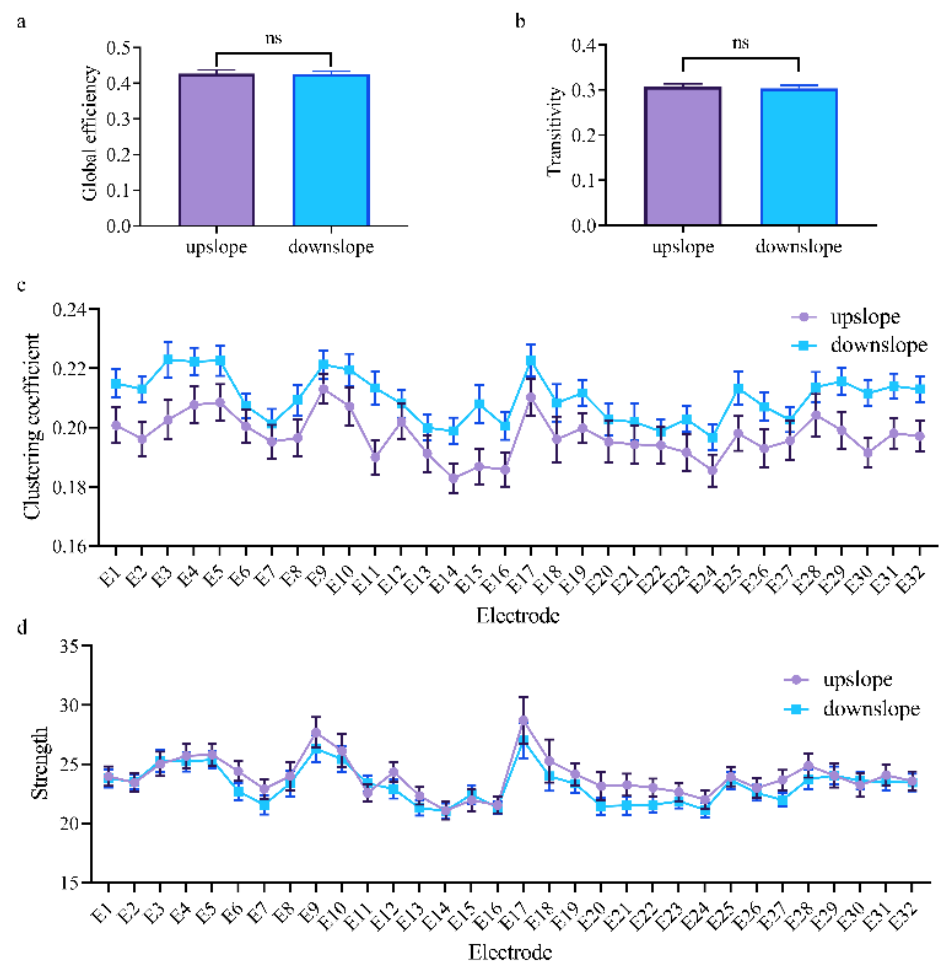
Figure 9. Indexes of the brain network for the two locomotion states in the high gamma band (50–100 Hz). ( a , b ) Global indexes of the brain network, including global efficiency and transitivity. ( c , d ) Local indexes of the brain network, including clustering coefficient and strength. All error bars indicate the 95% confidence interval of the mean. ns, not significant.